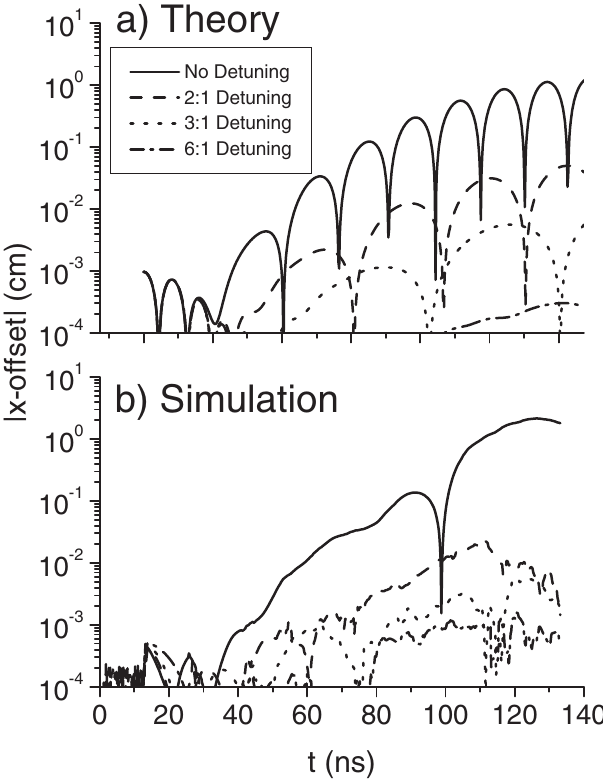
FIG. 8. Comparison of ion hose growth from (a) theory and (b) simulations with different detuning ratios. For these simulations (cid:6) 300 MeV , a (cid:6) 1 cm , (cid:13) (cid:6) 15 cm , L (cid:6) 300 cm , and E b p 0 (cid:14) (cid:6) 210 cm